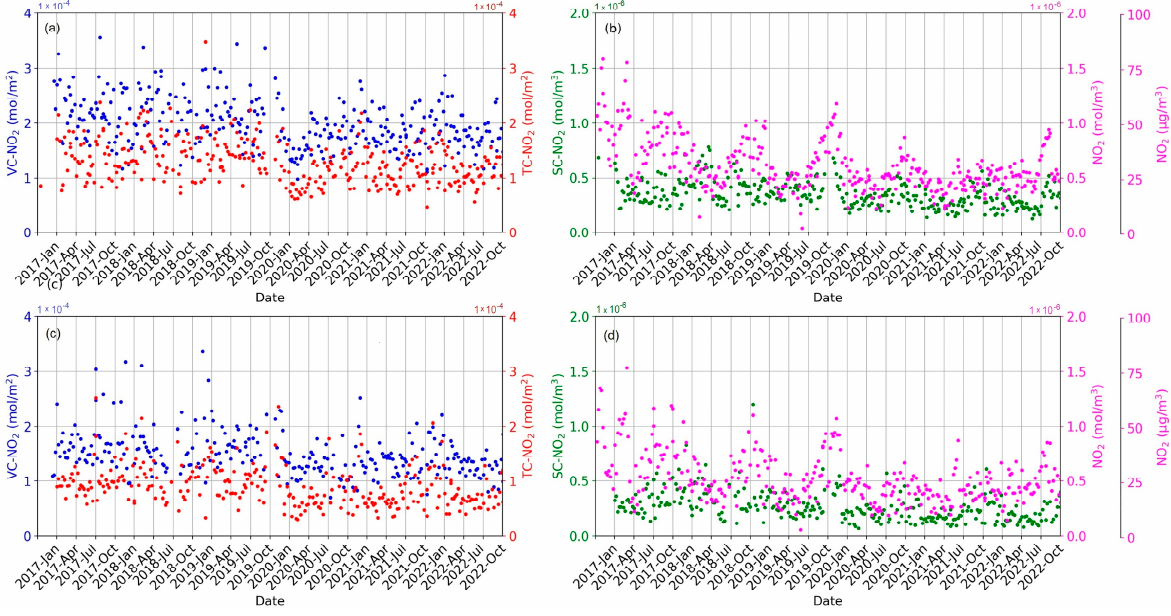
Figure 3. Weekly average time series of VC-NO 2 and TC-NO 2 for ( a ) weekdays and ( b ) weekends and SC-NO 2 and in situ NO 2 concentration for ( c ) weekdays and ( d ) weekends. VC-NO 2 , TC-NO 2, and SC-NO 2 are measured at Sapienza (SAP) from Pandora. In situ NO 2 concentrations are measured at the Villa Ada (VA) station.